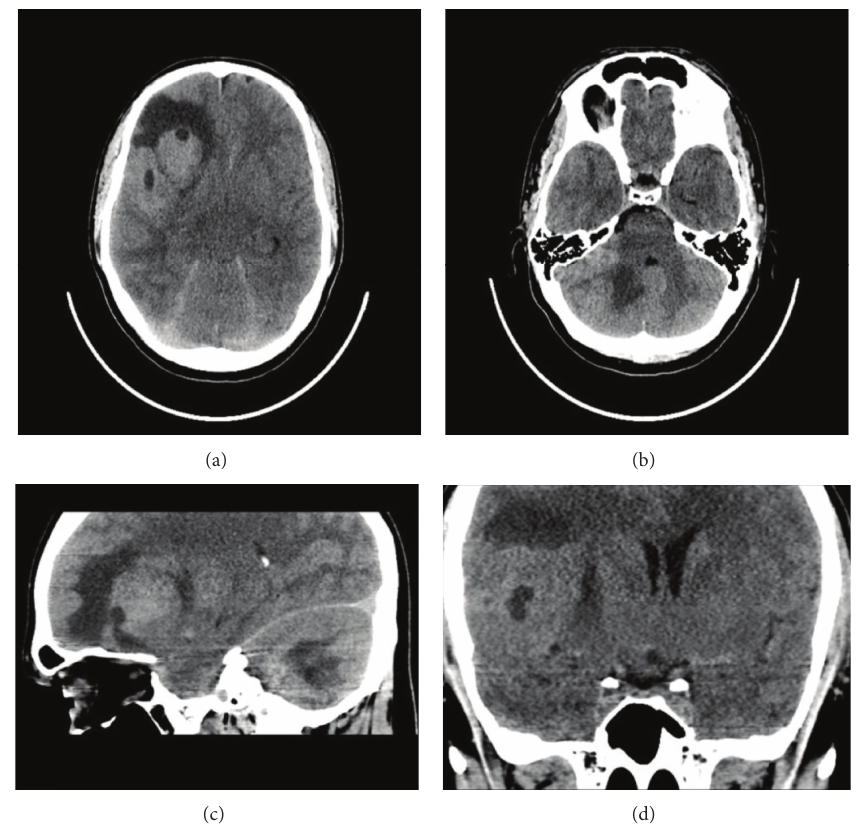
Figure 1: Axial CT acquisition (a)-(b) with sagittal (c) and coronal (d) multiplanar reformatted images showing a mild hyperdense complex lobulated mass in the right frontotemporal region associated with oedema and a similar smaller lesion in the right cerebellar lobe.